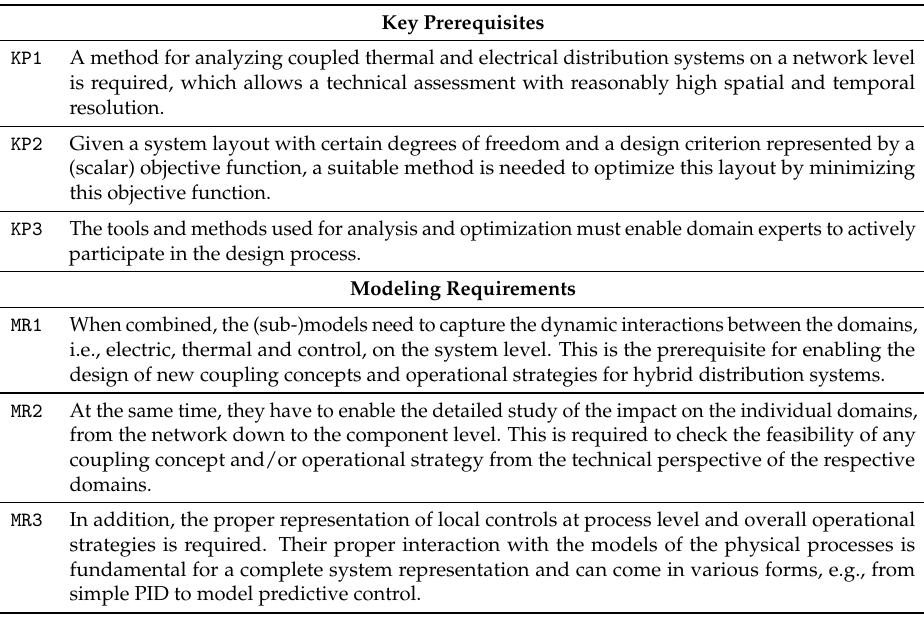
Table 1. Key prerequisites and modeling requirements for the assessment of hybrid